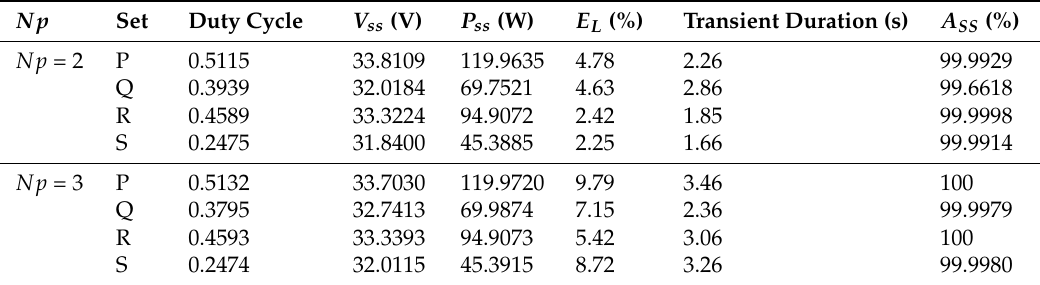
Figure 12. Simulation results under radiation variation and Np = 3 given by the Improved Particle Swarm Optimisation (IPSO) algorithm: ( a ) Duty cycle, ( b ) Voltage under irradiance change, and ( c ) Power under irradiance change. Table 7. Comparison performances of the proposed the Improved Particle Swarm Optimisation (IPSO) method when Np = 2 and Np =